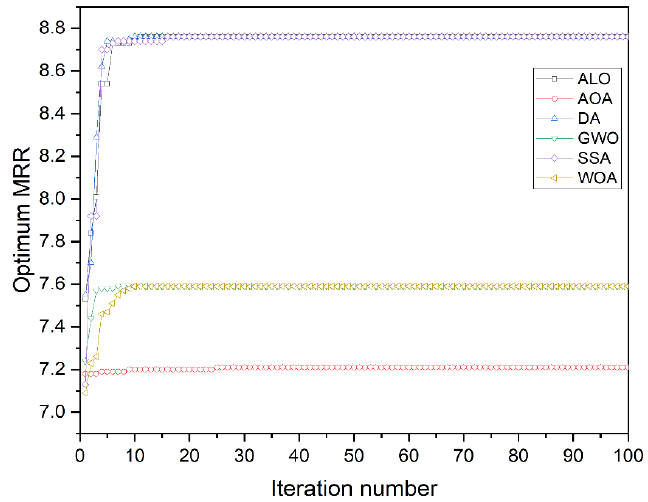
Figure 1. Convergence of optimum MRR with respect to iterations.